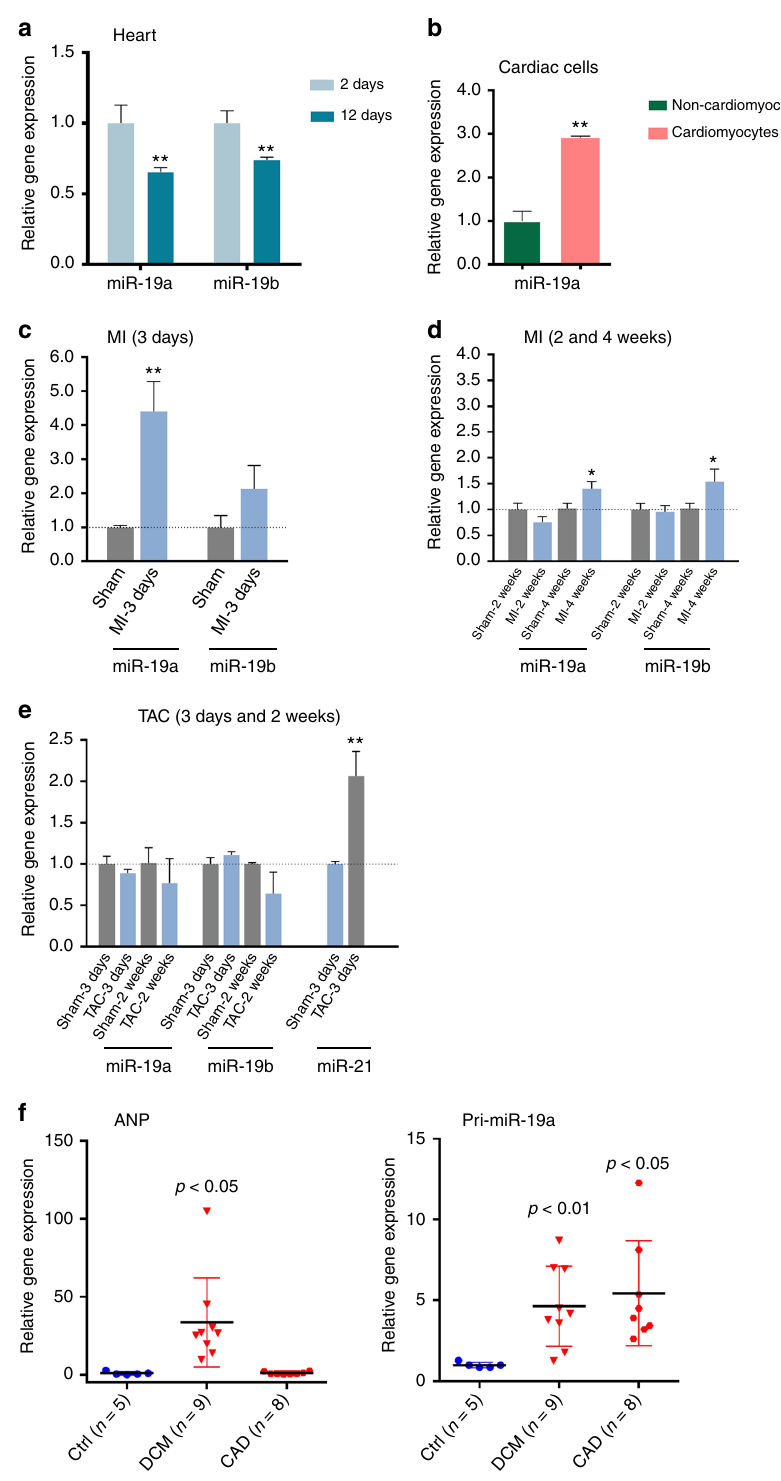
Fig. 1 Expression of mir-19a/miR-19b in the heart and cardiomyocytes. a qRT-PCR of miR-19a and miR-19b at 2 and 12 days postnatal mouse hearts. n = 3 mice. b In isolated adult cardiomyocytes and non-cardiomyocytes, qRT-PCR detection of the expression of miR-19a. n = 3 mice. c , d In mouse myocardial infarction (MI) model, qRT-PCR detection of the expression of miR-19a and miR-19b ( c ) at 3 days post-MI ( n = 6 mice) and ( d ) at 2 weeks and 4 weeks post-MI. n = 3 – 6 mice. e In mouse transverse aortic constriction (TAC) induced cardiac hypertrophy model, qRT-PCR detection of the expression of miR- 19a, miR-19b, and miR-21 at 3 days and 2 weeks post-TAC. Expression of miR-21 was considered as positive control. n = 2 – 3 mice. f In human heart disease samples, qRT-PCR detection of the expression of pri-mir19a in hearts with dilated cardiomyopathy (DCM) and coronary artery disease (CAD). The expression of ANF (encoded by Nppa ) was considered as positive control. All panels, statistical signi fi cance was calculated using Student ’ s t -test and data are presented as means± s.e.m. * p < 0.05, ** p < 0.01 vs. control. Source data are provided as a Source Data fi le